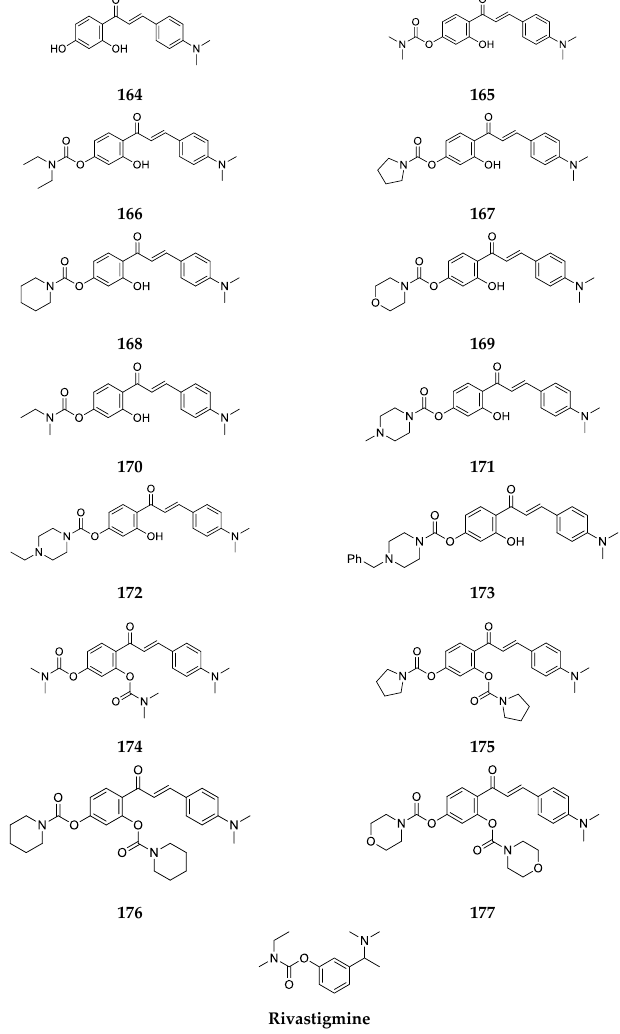
Figure 59. Chemical structure of N,N -dimethylated 4′-aminochalcone derivatives. Some more N,N -dialkyl compounds were synthesized for the same investigation (Figure 60).